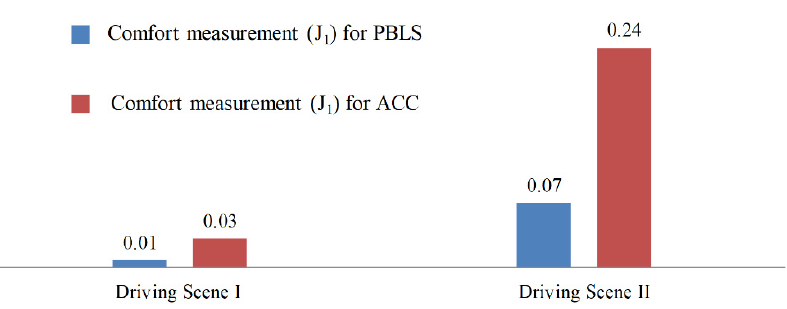
Figure 12. Comfort measurement ( J 1 ) for di ff erent systems in di ff erent scenes.